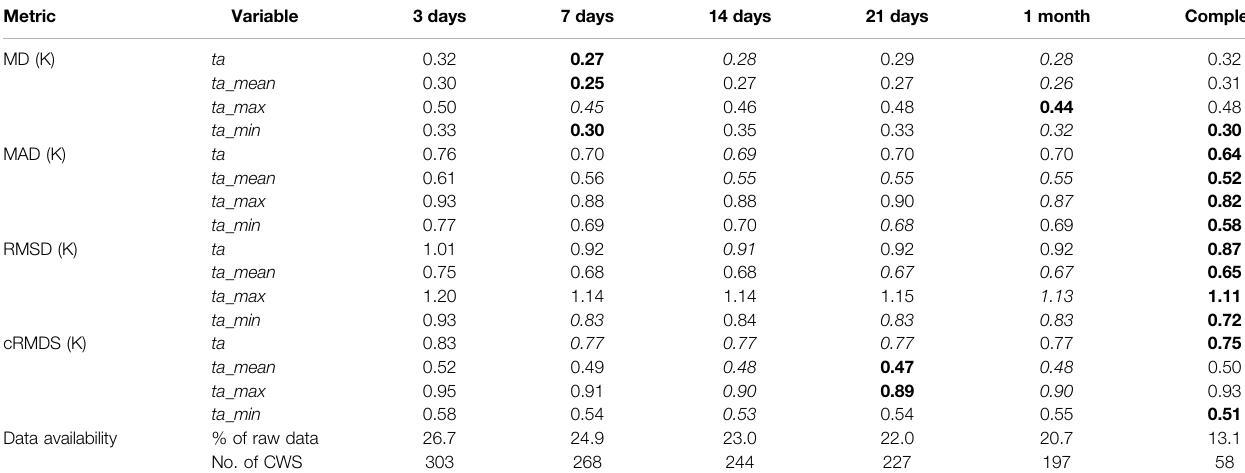
TABLE 4| Meanannualdeviationsinhourlyairtemperature ( ta )andinaggregated dailyvaluesofmean( ta_mean ),maximum ( ta_max ),andminimum( ta_min )betweenCWS andPRWSinAmsterdam,andremainingdataavailabilityduring2019afterapplyingCrowdQC+initsdefaultsetting(cf. Table2 ).DisplayedarevaluesatQClevelo3with different “ durations ” (in QC levels m3, m4, o3). Bold values mark best results per metric and variable, italic values second best. Deviations were calculated between each PRWS and each CWS within a radius of 2000 m around the respective PRWS, located in the same LCZ type as the PRWS. Deviations were then averaged across all CWS and PRWS. MD, mean deviation; MAD, mean absolute deviation; RMSD, root-mean-square deviation; cRMSD, centred RMSD.